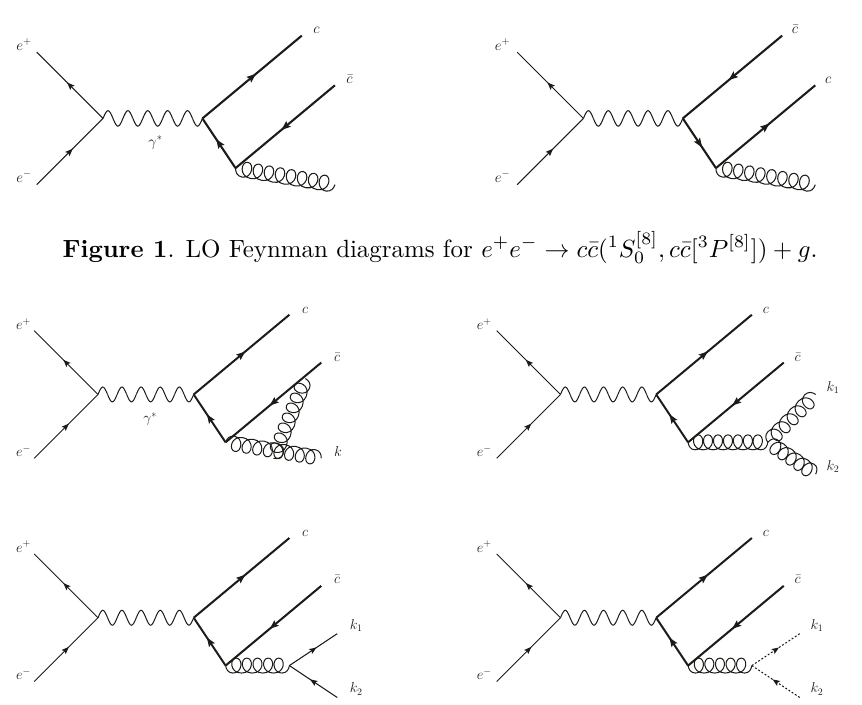
Figure 2 . Representative NLO Feynman diagrams for the c ¯ c [ 1 S [8]